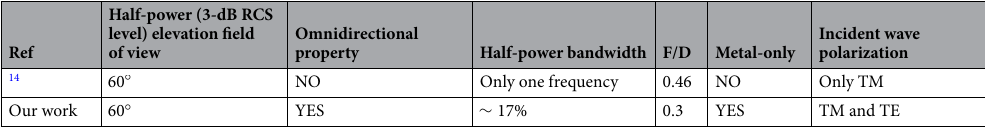
Table 3. Comparison of the proposed retroreflector with the reference 14